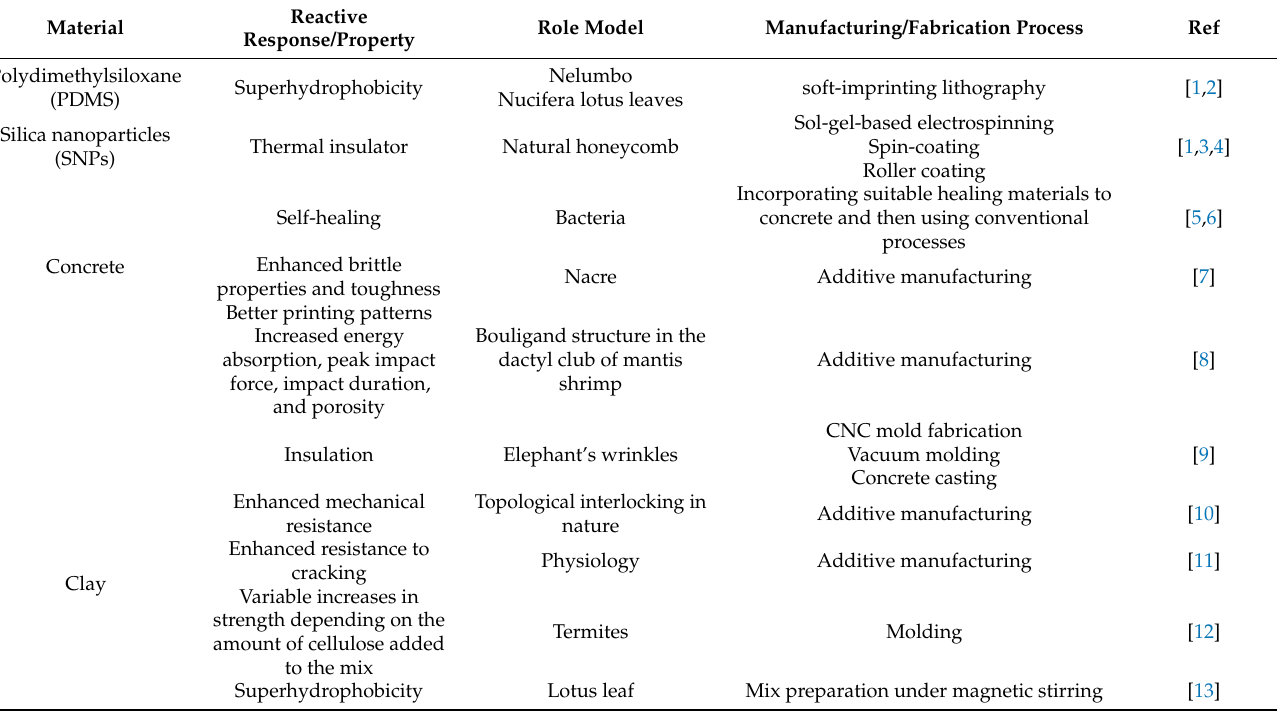
Table 2. Summary of the cases in which manufacturing and materials are addressed